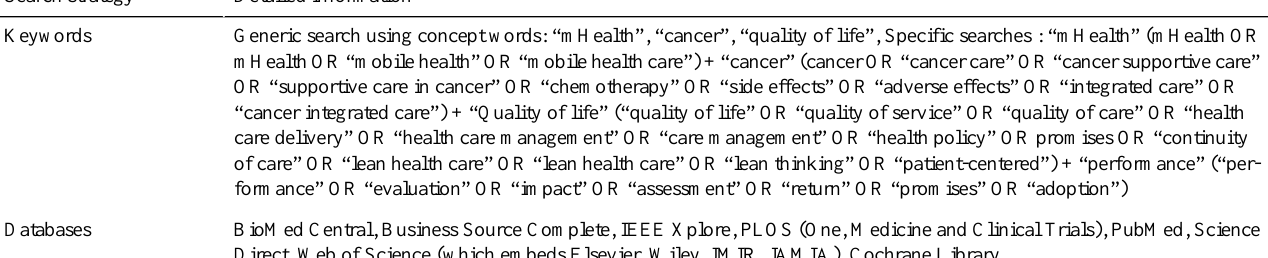
Detailed informationSearch